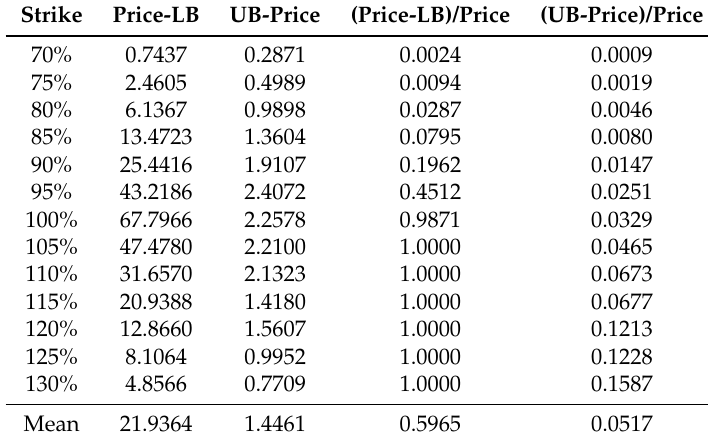
Table 3. Absolute and relative differences between the freight call option prices with a maturity of 3 months and their lower and upper bounds, for several strike